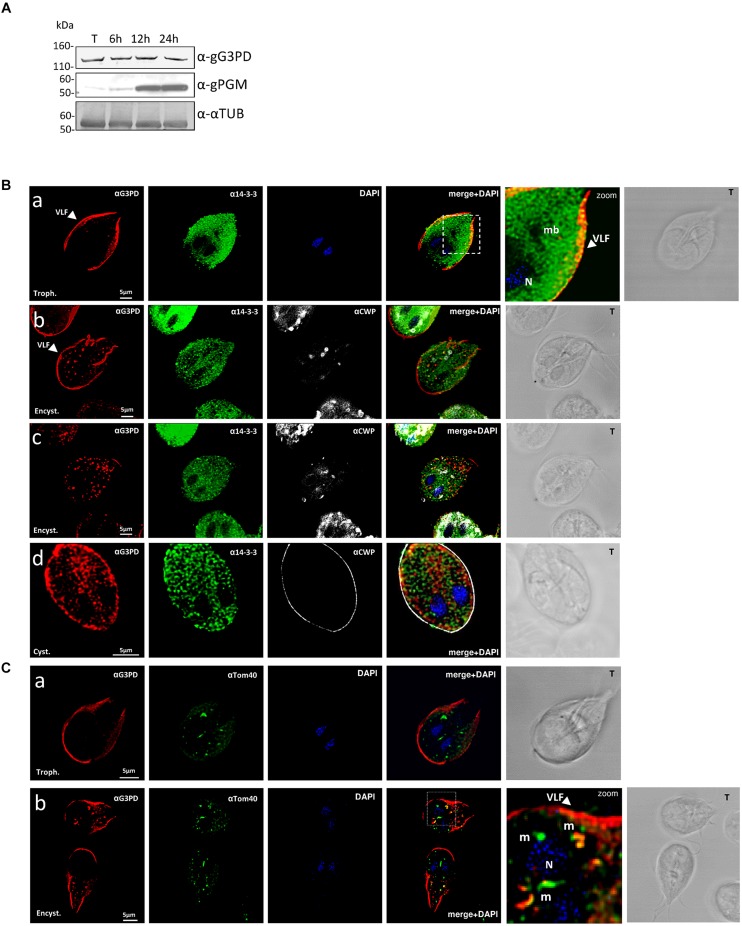
Expression and localization of the glycerol-3-phosphate dehydrogenase (gG3PD) during the differentiation stages of Giardia duodenalis. (A) Western blot from three independent analysis of Triton lysates (20 μg) from G. duodenalis WB-C6 trophozoites (T) and parasites harvested at 6, 12, and 24 h after encystation induction. Immunoblotting was performed with: anti-gG3PD polyclonal serum (α-gG3PD); anti-phosphoacetylglucosamine mutase (α-PGM) (Lopez et al., 2003), to follow the progression of encystation; the anti-α-tubulin (α-α-TUB), as loading control. Molecular size markers (kDa) are reported on the left. The analysis is representative of three independent experiments. (B) Confocal laser scanning microscopy (CLSM) observations of fixed and permeabilized G. duodenalis WB-C6 parasites at different stages: trophozoite (panel a, Trophozoite), encysting parasite after 12 h of encystation (panel b and c, Encystation) and cyst (panel d, Cyst) stained with the mouse polyclonal serum α-gG3PD (red) and the α-g14-3-3 rabbit polyclonal (green). Cyst wall and encystation specific vesicles (ESVs) were stained with Cy3-conjugated α-CWP mAb (gray). Nuclei (N) were stained with 4′,6-diamidino-2-phenylindole (DAPI; blue). Displayed micrographs correspond to a single z-stack: a and b, ventral stacks; c and d, central stacks encompassing the nuclei. T, transmission light acquisition. Scale bars, 5 μm. Arrows indicate the ventrolateral flanges (VLF). A magnification (zoom) of the indicated area in the merged image is shown. (C) CLSM observation as in (B). Parasites were stained with α-gG3PD (red) and α-Tom40 antiserum (green; Dagley et al., 2009). Nuclei (N) were stained with DAPI (blue). A magnification (zoom) of the indicated area in the merged image is shown. Mitosomes are indicated (m). Images in (B) and (C) are representative of >50 fields analyzed in two independent experiments.